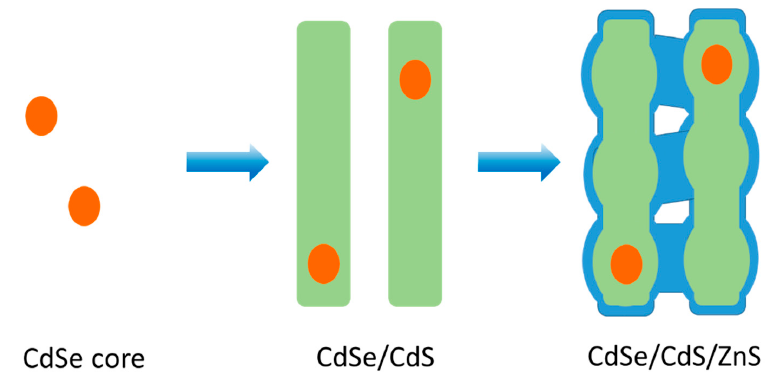
Figure 3. Schematic diagrams of the growth of CdSe / CdS / ZnS